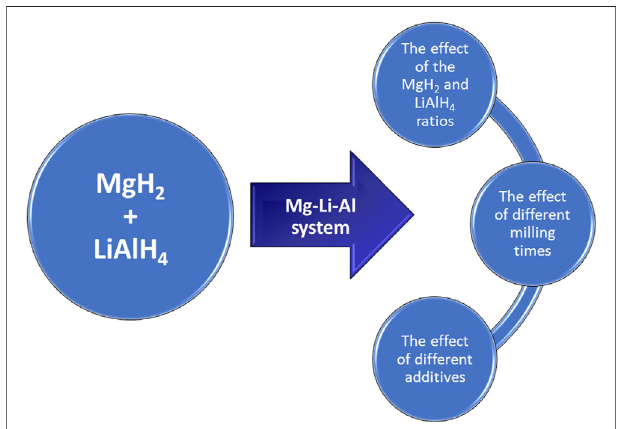
FIGURE 2 | Schematic representation of the main topics discussed in this review.